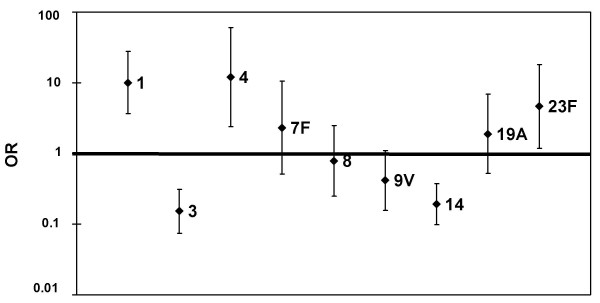
Serotype specific empiric odds ratio (OR) and 95% confidence intervals.